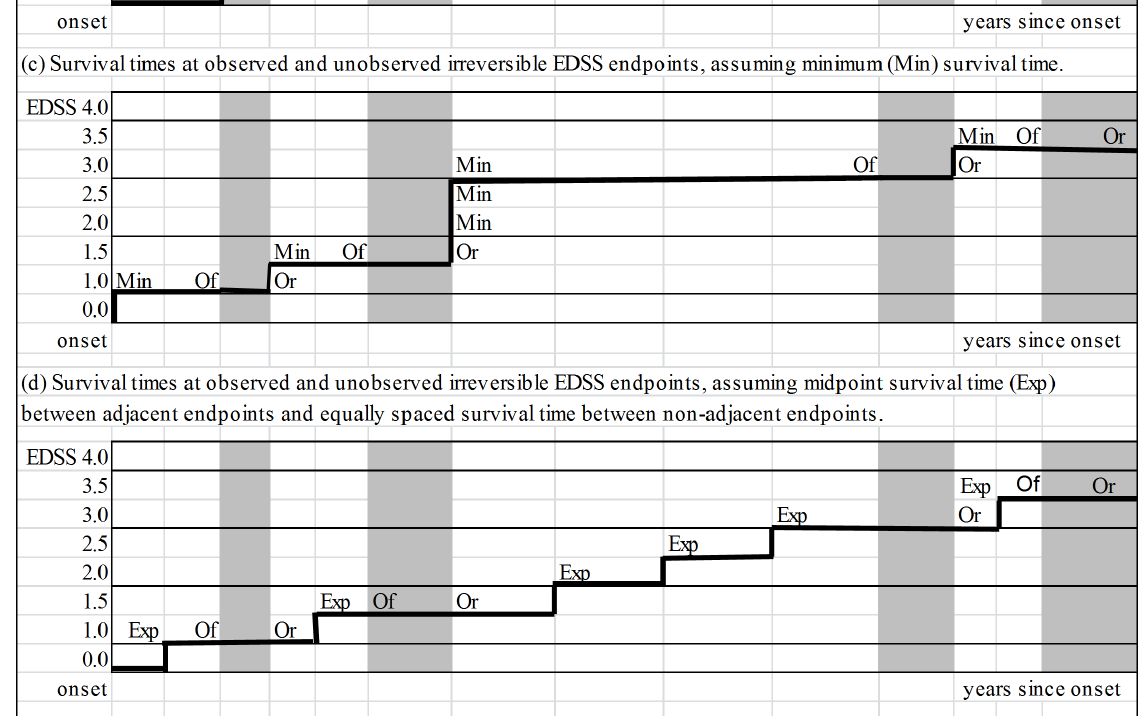
Figure 2. Irreversible progression paths – assuming maximum, minimum or midpoint survival time. Footnote: Part (a) shows a hypothetical multiple sclerosis patient’s clinical observations by years since onset. EDSS=Expanded Disability Status Scale. EDSS=0 at onset is assumed. Of=first clinical observation at an irreversible EDSS endpoint. Or=last repeat clinical observation at an irreversible EDSS endpoint (repeat clinical observations between Of and Or are not shown). Ot=a transitorily high EDSS clinical observation (Ot are not shown in parts (b), (c) and (d)). Max=maximum survival time. Min=minimum survival time. Exp=expected midpoint survival time. bold lines =irreversible disability progression paths. doi:10.1371/journal.pone.0105123.g002 signifying faster progression. The differences between midpoint disability range EDSS 0–3 than in disability range EDSS 3.5–6, and maximum survival curve estimates are significantly larger in and become progressively smaller beyond EDSS 6; this pattern